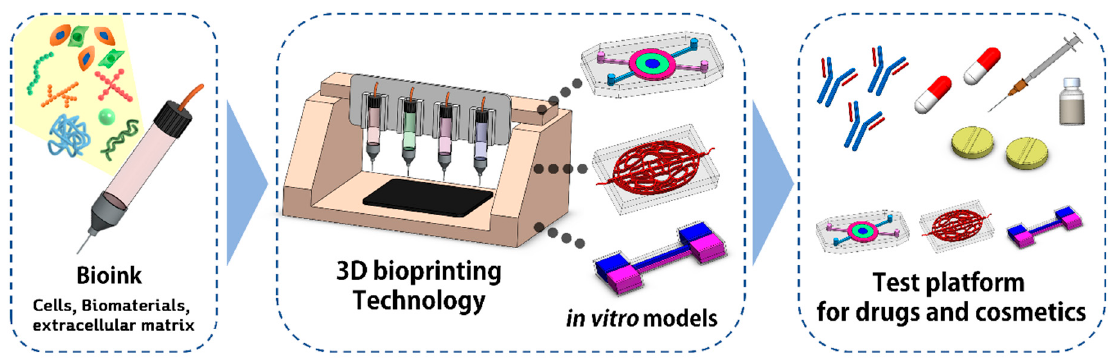
Figure 1. Manufacture of in vitro test models with bioinks and bioprinting.